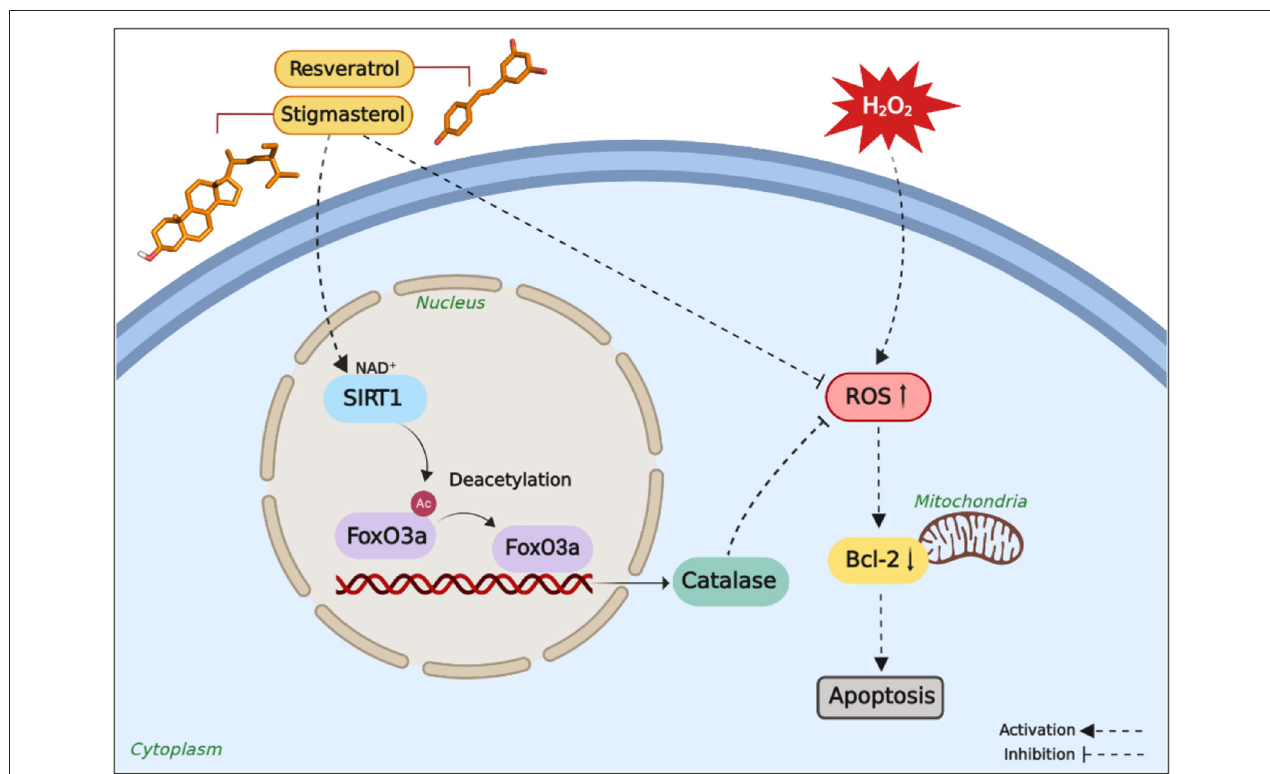
FIGURE 7 | Potential neuroprotective pathways regulated by stigmasterol are comparable to resveratrol. Stigmasterol protects SH-SY5Y cells from H 2 O 2 -induced oxidative stress via stimulation of SIRT1-FoxO3a signaling pathway and promoting equilibrium of the antioxidant system, thereby reducing excessive ROS accumulation, attenuating neurodegeneration and apoptosis, and eventually promoting cell survival (Figure created with BioRender.com).